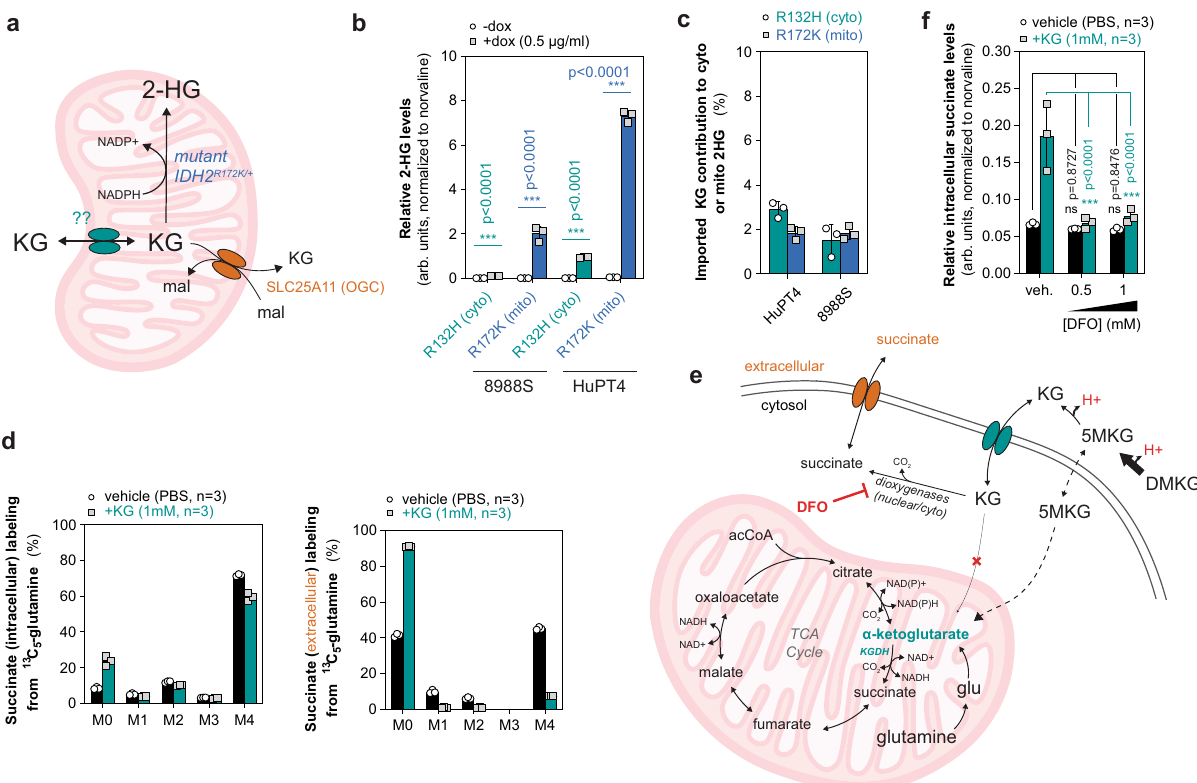
Fig. 6 KG metabolism is functionally compartmentalized in cells. a Schematic of mitochondrial production of 2-hydroxyglutarate (2-HG) from mutant IDH2 R172K/ + as a sensor of mitochondrial KG labeling. SLC25A11/OGC is an integral component of the malate-aspartate shuttle and exchanges mitochondrial KG with cytosolic malate; however, whether mitochondrial KG can import into mitochondria is unknown. b Relative cytosolic or mitochondrial 2-HG production from dox-inducible expression of IDH1-R132 (R132H, cyto) or IDH2-R172K (R172K, mito), respectively, in HuPT4 and 8988S cells after 24 h dox-induction (0.5 µ g/ml) normalized to norvaline levels. Data are mean ± s.d., n = 3 biologically independent samples; signi fi cant determined by two-tailed Student ’ s t -test corrected for multiple comparisons, *** p < 0.0001. c Minimal label incorporation from imported KG into cytosolic or mitochondrial 2-HG production from R132H or R172K labeled with 13 C 5 -glutamine with or without 1 mM of KG for 24 h in 8988S and HuPT4 cells. IDH1- R132H or IDH2-R172K expression was induced using 0.5 µ g/ml at the time of labeling. Data are plotted as the difference in %(100-MPE) from 13 C 5 - glutamine between KG-supplemented and control (PBS) conditions, which represents the percentage of carbon that KG contributes to 2-HG production, mean ± s.d., n = 3 biologically independent samples. d Mass isotopologue distribution of intracellular (left panel) or extracellular (right panel) succinate labeling from HuPT4 cells cultured with 13 C 5 -glutamine with or without 1 mM of unlabeled KG for 24 h. Secreted succinate is a surrogate measurement of the cytosolic pool. Data are mean ± s.d., n = 3 biologically independent samples. e Schematic of DMKG hydrolysis and deprotonation and cellular import of KG and 5MKG and metabolism by cytosolic and/or nuclear dioxygenases to produce succinate, which can be secreted. Minimal contribution of imported KG was observed in mitochondrial TCA cycle intermediates, but DMKG/5MKG was able to contribute to the TCA cycle. Deferoxamine (DFO) is an iron chelator, which broadly inhibits KG-dependent dioxygenase activity. Acetyl-CoA (acCoA), glutamate (glu). f Treatment of 8988T cells with DFO (500 µ M or 1 mM) for 24 h signi fi cantly inhibits the increase in intracellular succinate levels from KG supplementation. Data are representative mean ± s.d., n = 3 biologically independent samples from two independent experiments; signi fi cance determined by two-way ANOVA using Dunnett ’ s multiple comparisons test, n.s. p > 0.05, *** p < 0.0001. IDH2-R172K in 8988S and HuPT4 cell lines. All cell lines pro- duced a detectable level of 2-HG over baseline after 24 h dox- induction of mutant IDH1-R132H or IDH2-R172K (Fig. 6b). We